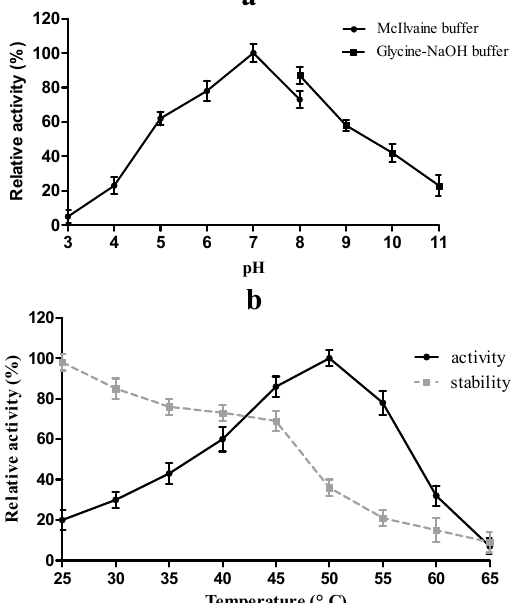
Figure 5. Effects of pH and temperature on the activity of AgaML. ( a ) Effect of pH on enzyme activity was measured in 0.05 M McIlvaine buffer with pH range from 3.0 to 11.0; and ( b ) Effect of temperature on enzyme activity were measured at temperatures ranging from 25 to 65 °C. Thermo stability analysis was observed after preincubation at temperatures ranging from 25 to 65 °C for 1 h. The error bars represent the means ± standard deviation (SD) ( n = 3).